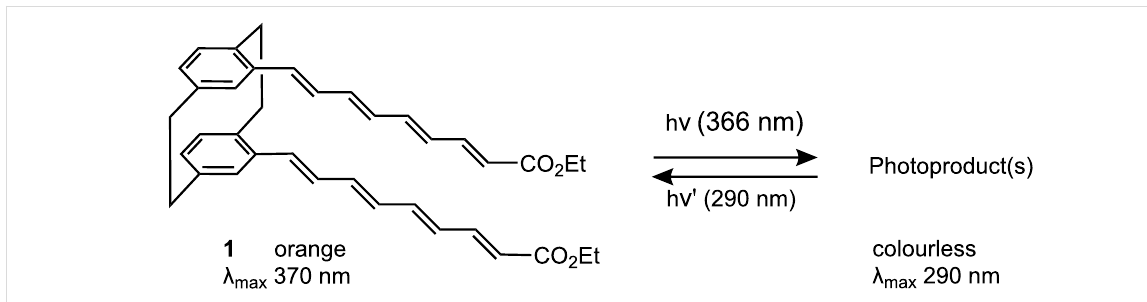
Figure 2: Photochromic reaction of pseudo-gem disubstituted tetraene [2.2]cyclophane 1 in acetonitrile, conc. 5 × 10 −4 M.